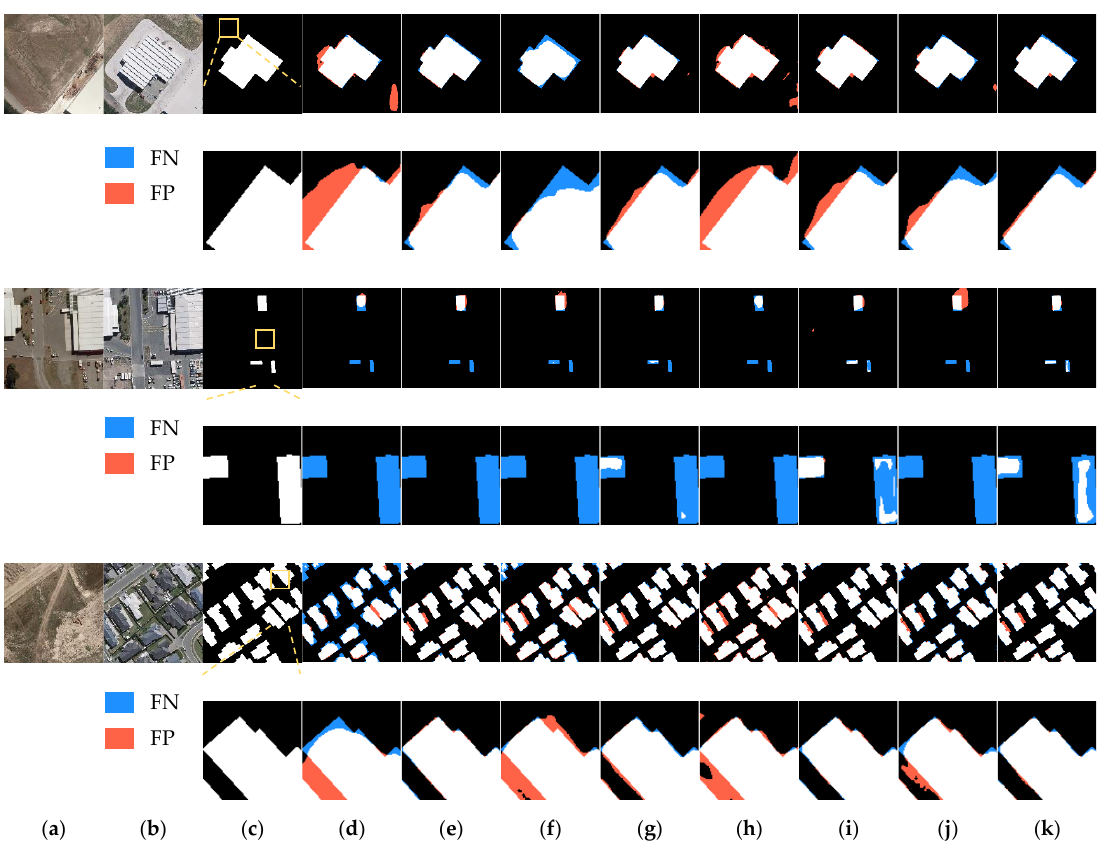
Figure 5. Visualization of ablation study on the BCDD dataset: ( a , b ) are bitemporal images; ( c ) the ground truth; ( d ) baseline; ( e ) baseline + FPN; ( f ) baseline + scSE; ( g ) baseline + FPN + scSE; ( h ) baseline + Seg; ( i ) baseline + Seg + FPN; ( j ) baseline + Seg + scSE; ( k )baseline + Seg + FPN + scSE. Changed pixels are indicated by white, whereas unchanged areas are shown in black. Red and blue represent false and missed detections, respectively.